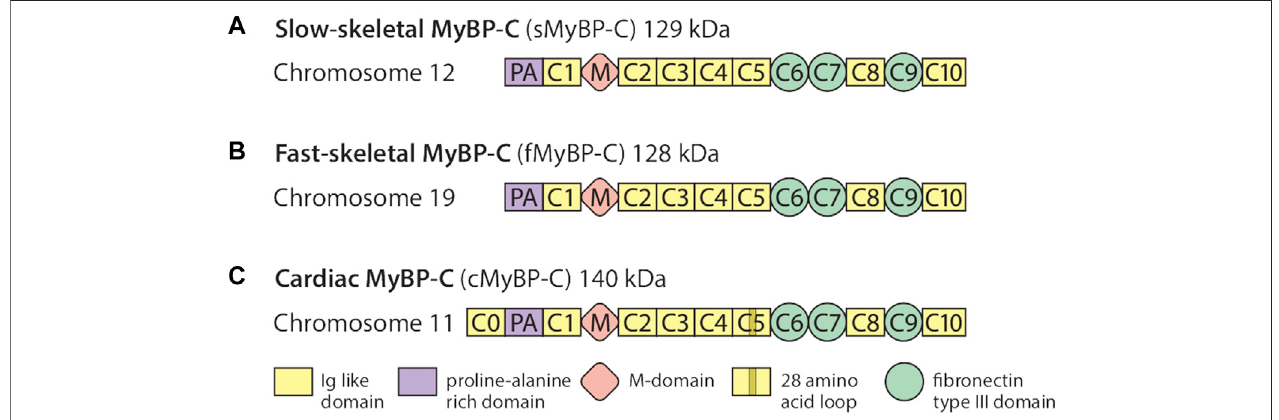
FIGURE 1 | The MyBP-C family consists of one cardiac and two skeletal paralogs. sMyBP-C is a 129 kDa protein encoded by the MYBPC1 gene contained in chromosome 12 (A) , and fMyBP-C is a skeletal muscle-speci fi c protein encoded by the MYBPC2 gene contained in chromosome 19 (B) . The two skeletal paralogs share similar domains, from C1 to C10, which contain three fi bronectin type III domains (C6, C7, and C9) and seven immunoglobulin-like domains with one Proline- Alanine(PA)-richdomainandphosphorylation(M)domains.The140 kDacMyBP-Cisencodedbythe MYBPC3 gene (C) andalsosharesstructuralfeaturessimilar to those of the skeletal paralogs, except it has one additional domain in its N ′ -region (C0). It also has a 28-amino acid loop in its C5